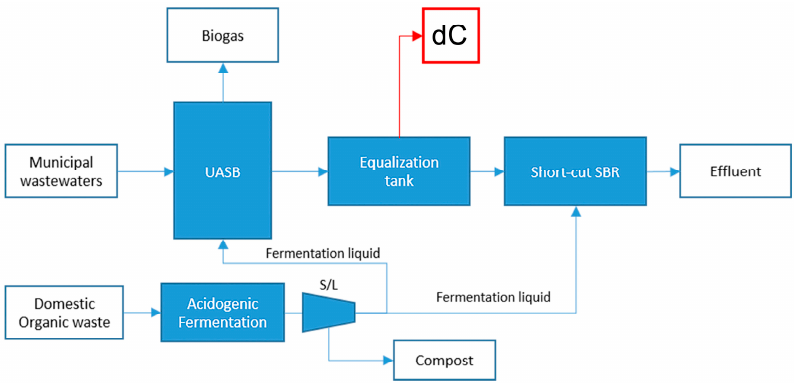
Figure 8. Schematic view of treatment plant producing digestate dC.